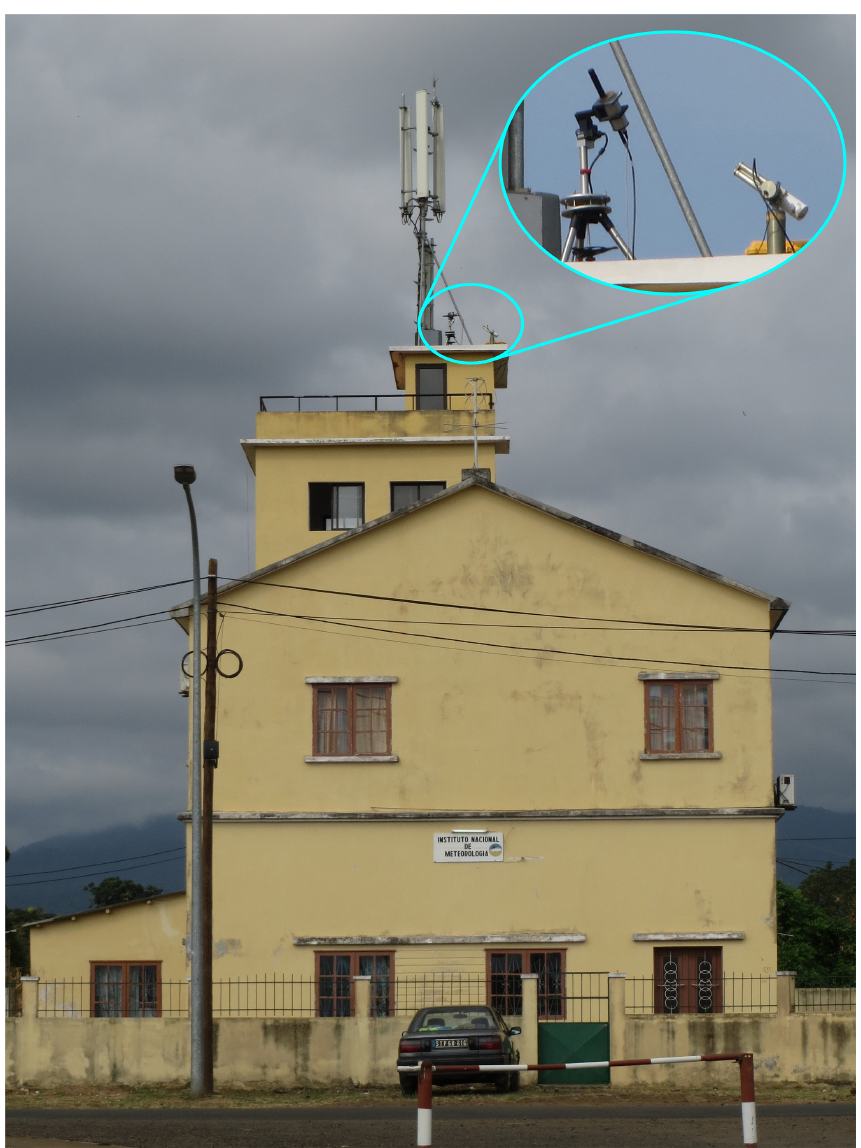
Figure 5. A picture of the STP Instituto Nacional de Meteorologia (INM), with an inset of the Pandora and AERONET instruments tem- porarily installed on the rooftop. Photo credit: James